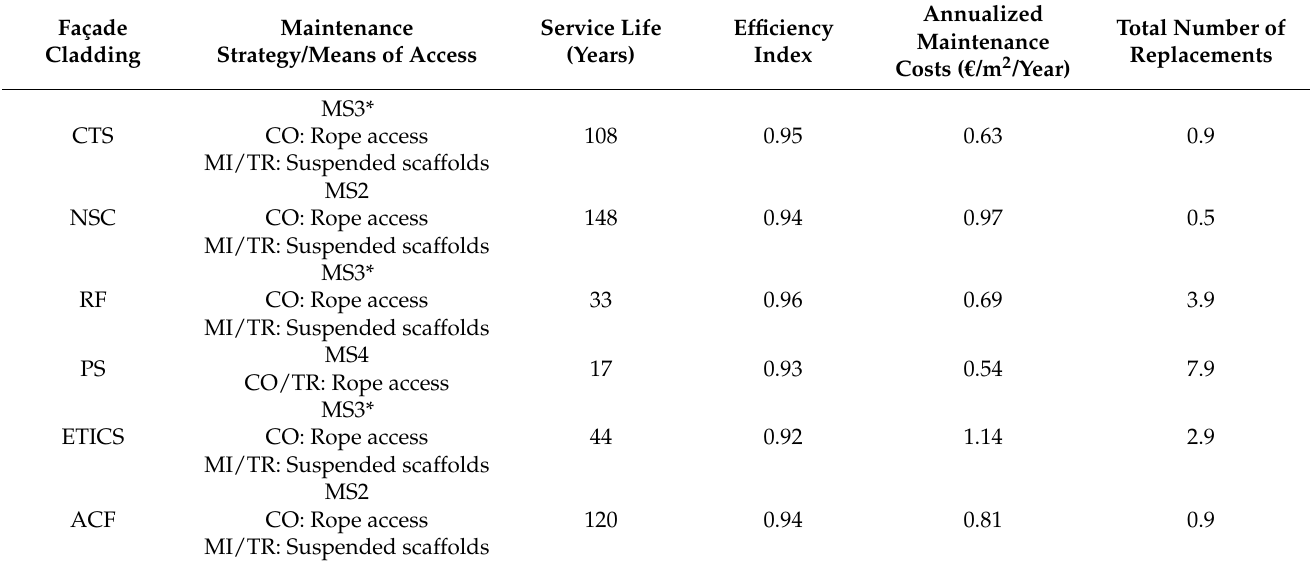
Table 5. Unit costs, at year 0, for the different maintenance activities without the means of access costs. Façade Maintenance Cladding Strategy/Means of